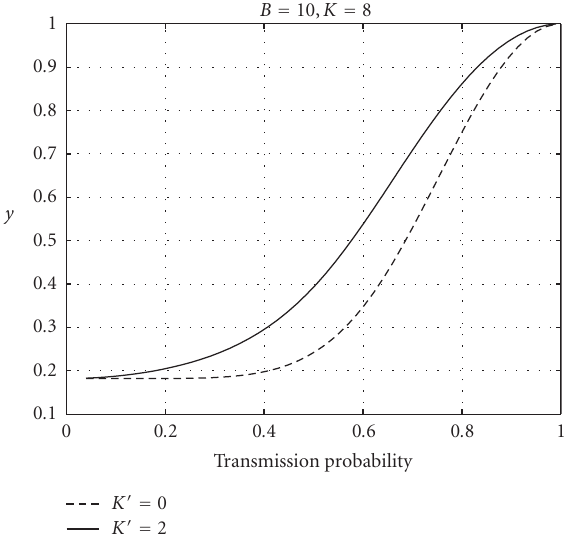
Figure 5: Average throughput for the linear case with static and dynamic K